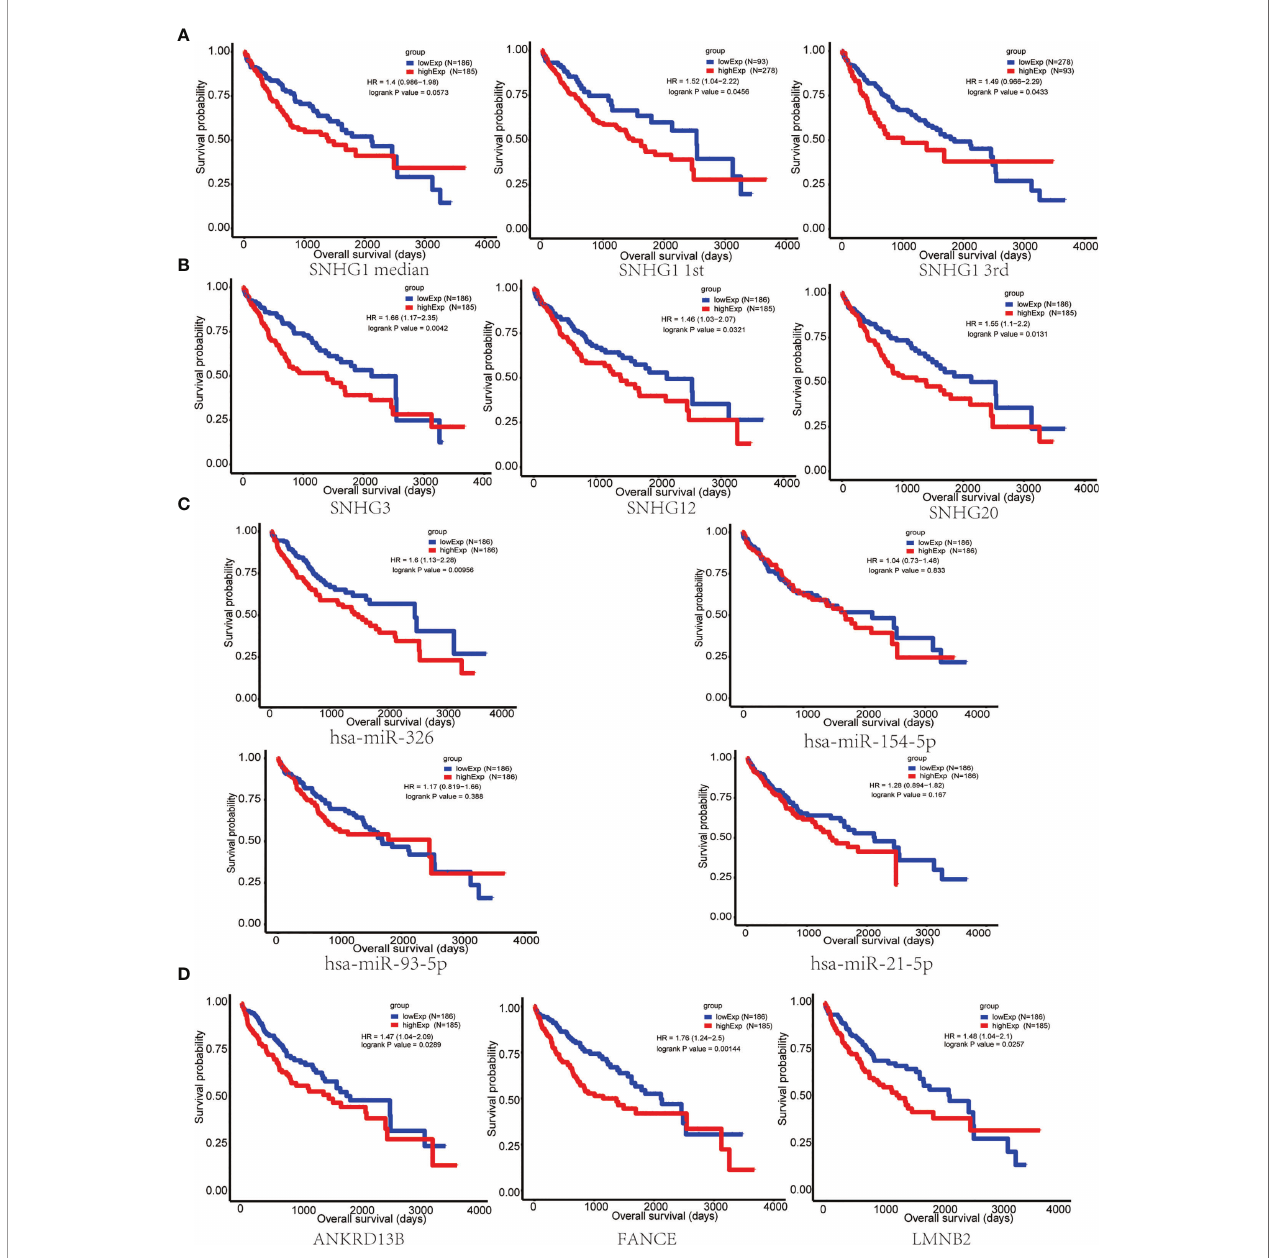
FIGURE 3 | Survival analysis of key nodes in hepatocellular carcinoma (HCC). (A) Kaplan – Meier curve of HCC patients with low or high SNHG1 expression of the quartile subgroups. (B) SNHG3 , SNHG1 2, and SNHG20 were signi fi cantly associated with the overall survival in patients with HCC, as detected using the Kaplan – Meier curve. (C) Kaplan – Meier curve of HCC patients with low or high expression of miR-326 , miR-154-5p , miR-21-5p , and miR-93-5p . (D) The Kaplan – Meier curve showed that ANKRD13B , FANCE , and LMNB2 were signi fi cantly associated with the overall survival in patients with